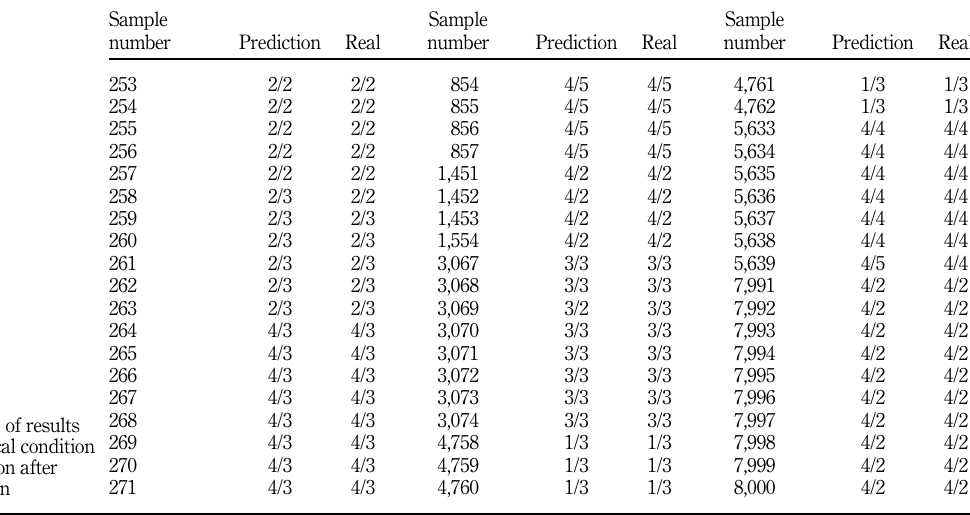
Table 3. Some parts of results on geological condition identification after